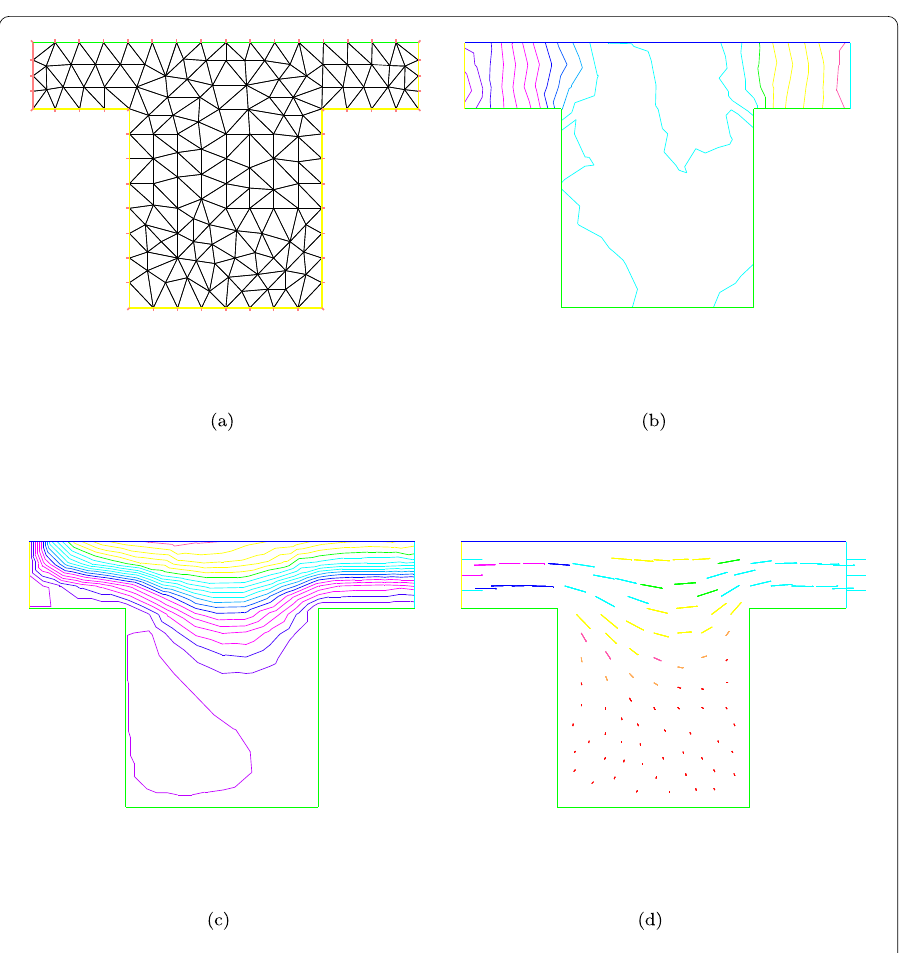
Figure 6 The mesh, the profiles of pressure and velocity, and the velocity vector with NT =